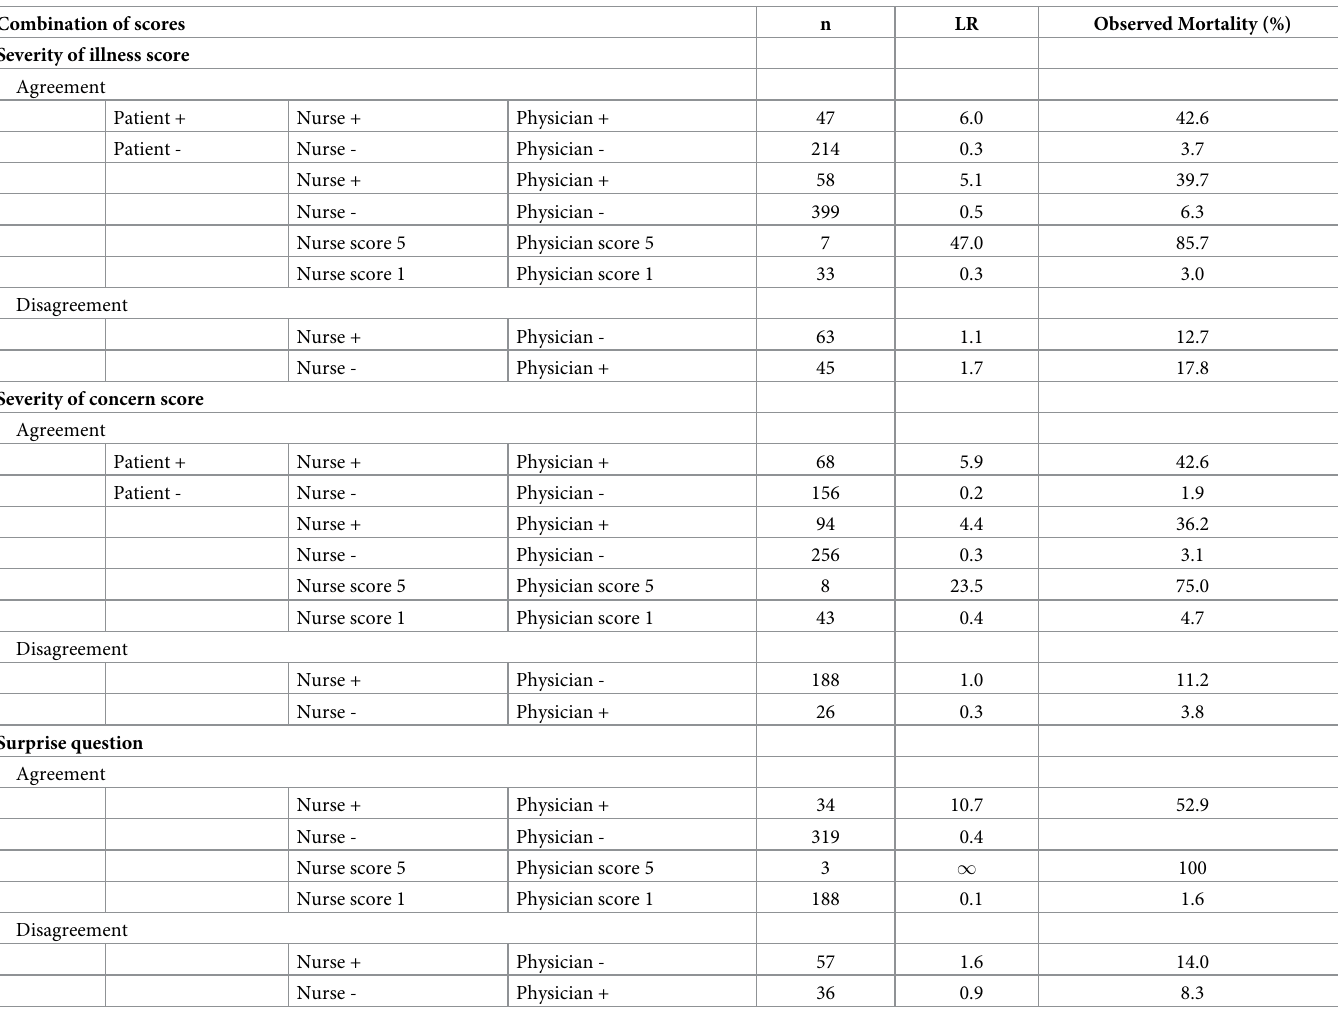
Table 5. Likelihood ratios of combined scores for 30-day